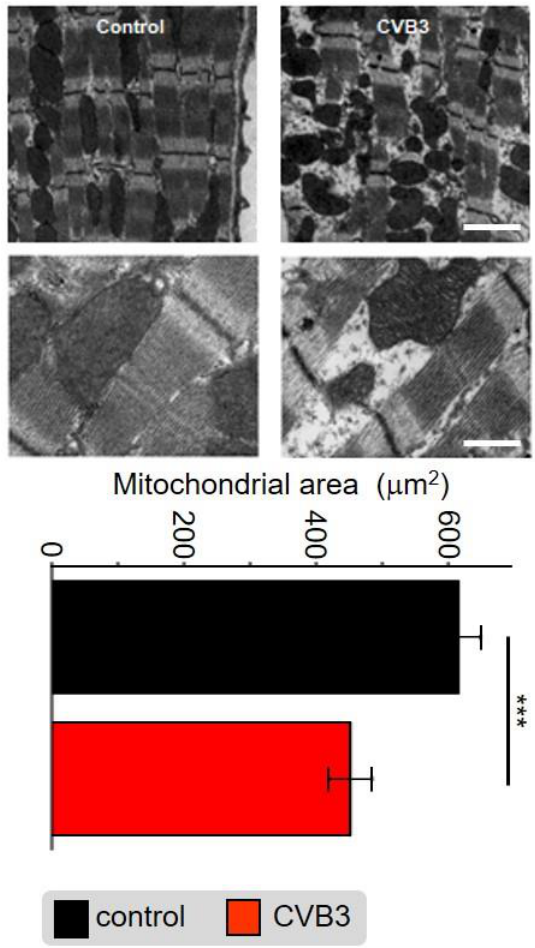
Figure 5. Electron microscopic image of sarcomeric structures with co-localized mitochondria of mouse cardiomyocytes from wt mice (left) and CVB3 Δ VP0-expressing mice (right). Scale bar top right — 100 nm, scale bar bottom right — 30 nm. Statistical analysis of the mitochondrial area in mouse cardiomyocytes from wt mice and CVB3 Δ VP0 expressing mice shows mitochondrial degradation due to CVB3 expression (*** indicates p < 0.001; n = 5).